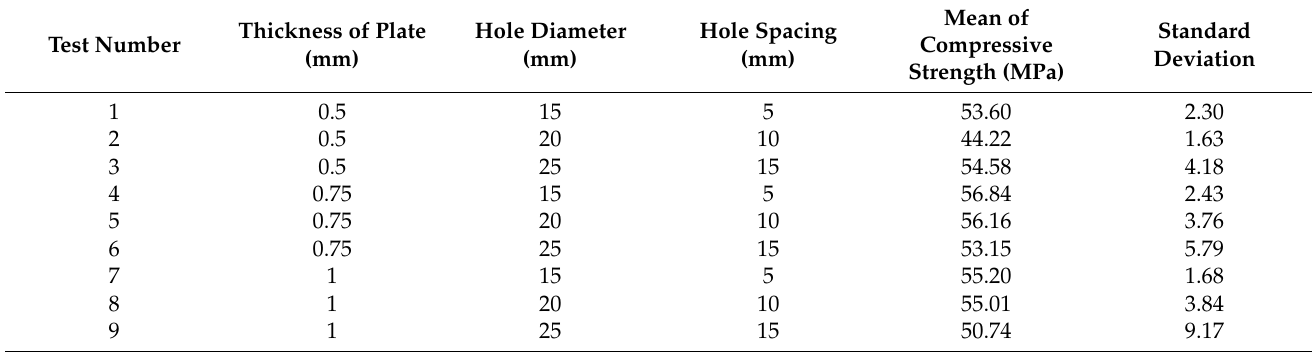
Table 4. Compressive strengths of two-way compression specimens.